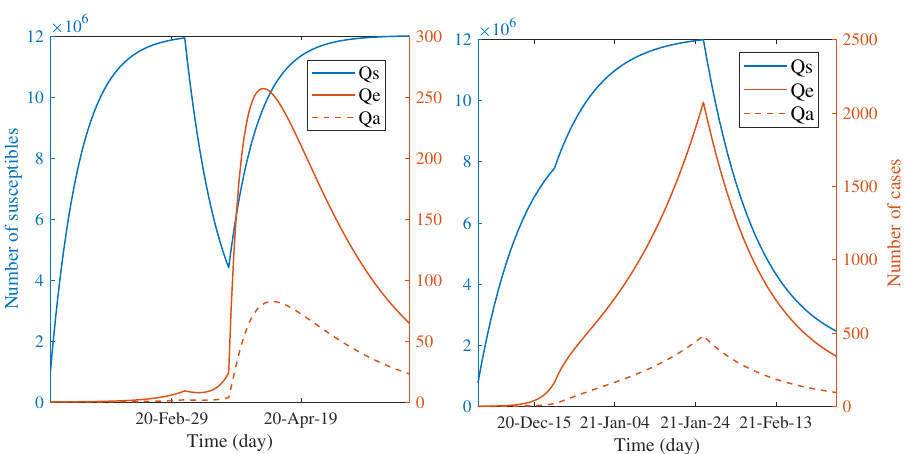
Figure 4. Dynamics of the quarantined people during the epidemic calculated by models. Left and right figures present the number of susceptible, exposed, and asymptomatic individuals that were quarantined in the first wave and in the second wave, respectively. Both figures are plotted with two different scales on the y -axis (colors), where the left (blue) represents the number of susceptible people in quarantine and the right (red) represents the number of infected people in